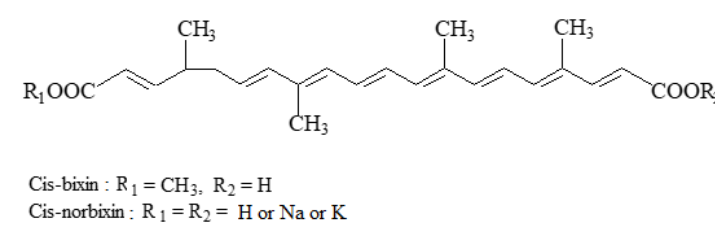
Figure 6. Structural formulae of bixin and norbixin colourant components.